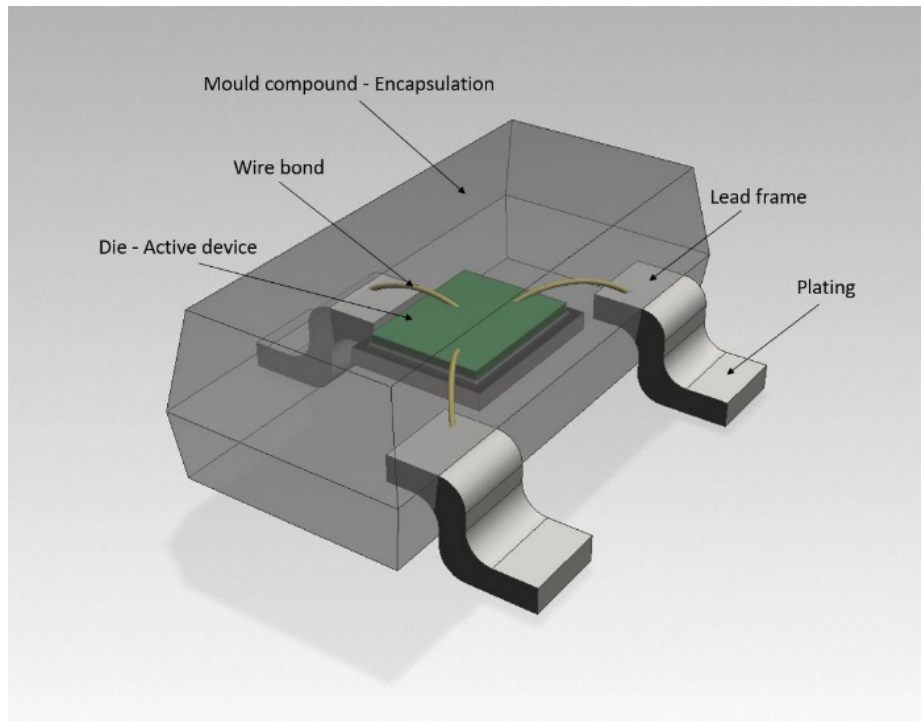
Figure 1. Schematic view of the parts of an SMD diode.